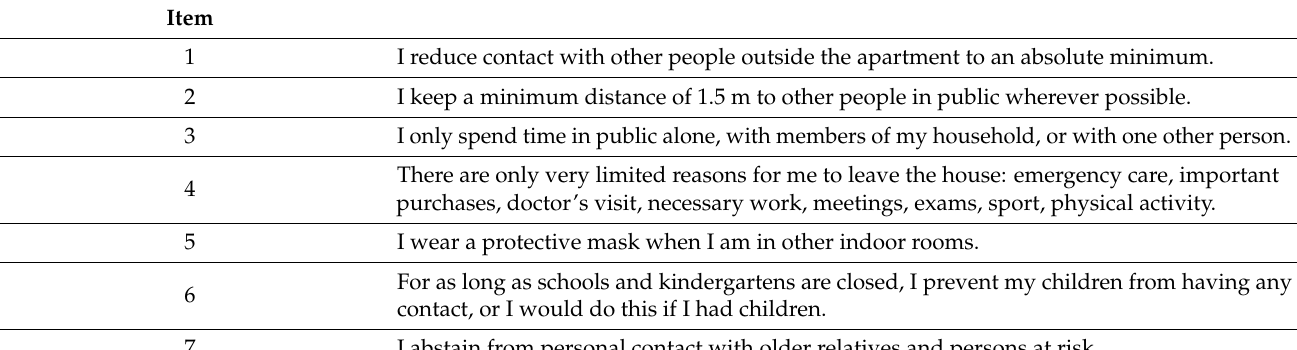
Table 1. Behavioral pre- and post-intervention measures as presented in the